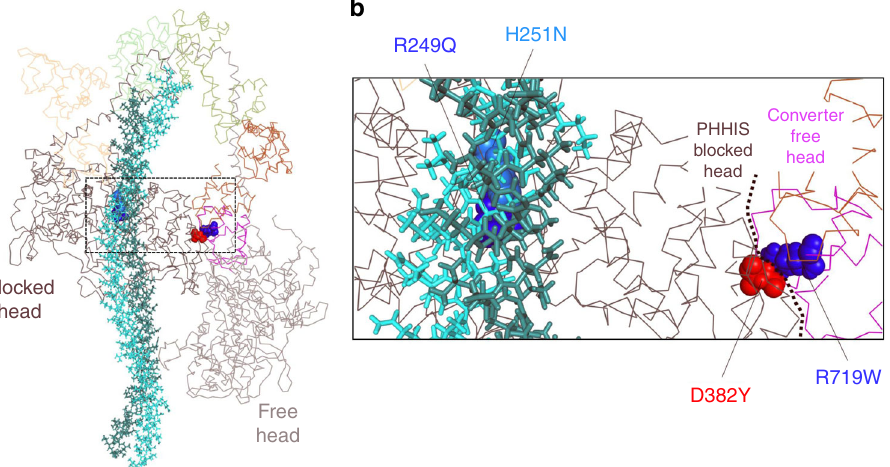
Fig. 1 Location of mutated residues on folded back model of human β -cardiac myosin. a Model of the back-side view of the human β -cardiac myosin IHM (MS03 homology model 26 ), with the alpha-carbon backbones of the two S1 heads and the light chains shown as lines, and the S2 tail region represented by sticks. The four residues mutated in this study are represented by spheres. b Close up of region outlined by the dashed box in fi gure a showing the mutated residues R249Q (blue) and H251N (light blue) at the head-tail interface and D382Y (red) and R719W (blue) at the head – head